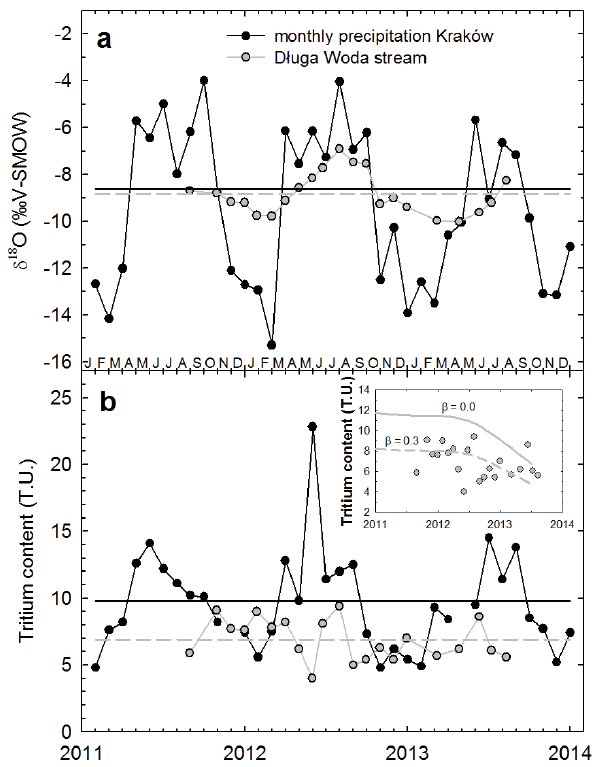
Figure 9. Seasonal variations of δ 18 O (a) and tritium content (b) in the Dluga Woda stream during the period 2011–2013. The inset in (b) shows the comparison of modelled and measured tritium con- centrations in the Dluga Woda stream. β is the fraction of tritium- free component in the total flow of the stream (see text for details).